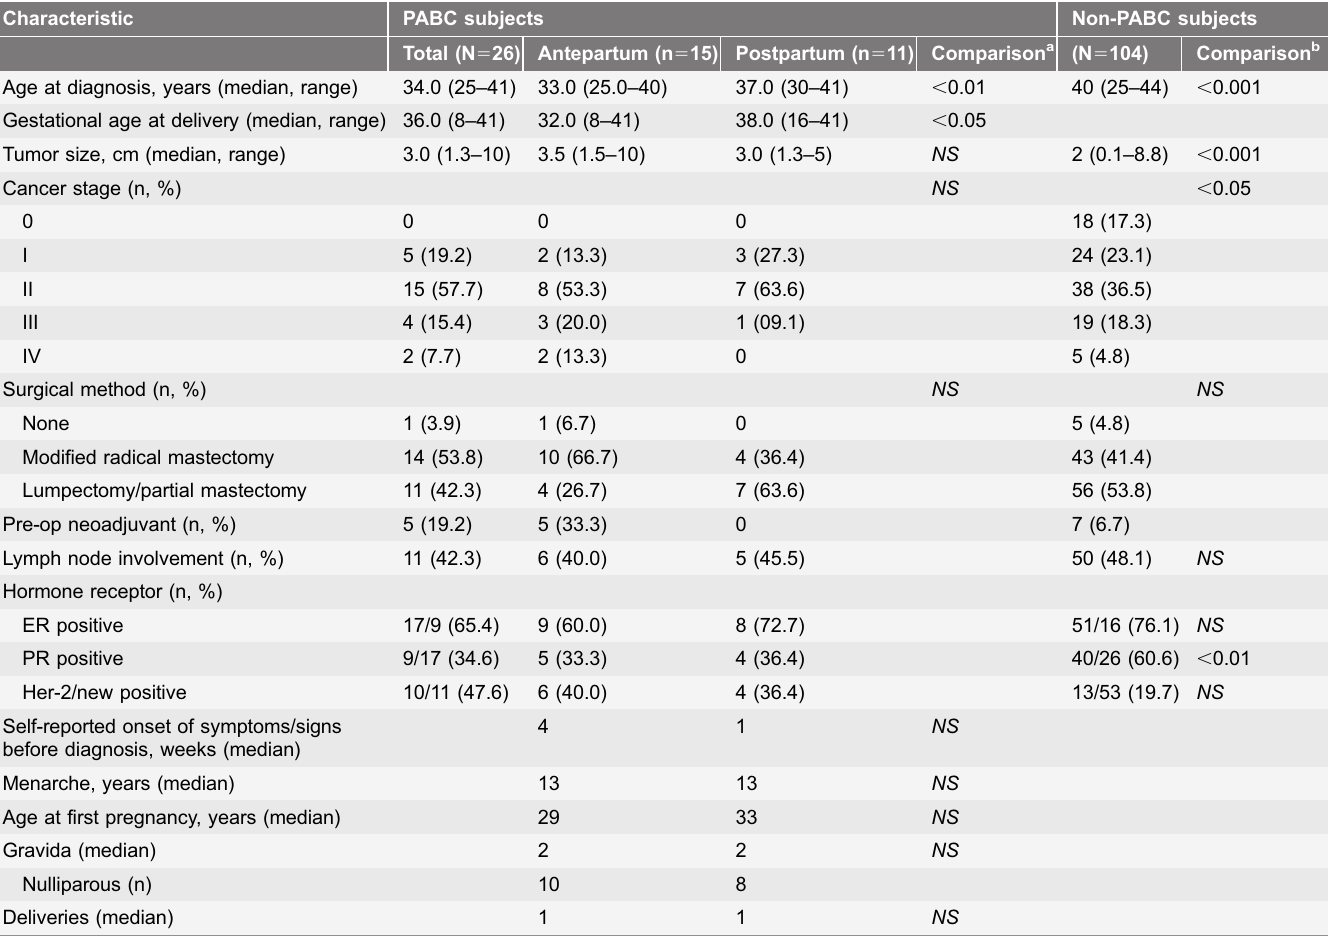
Table 1. Demographic and clinical characteristics of patients with and without pregnancy-associated breast cancer